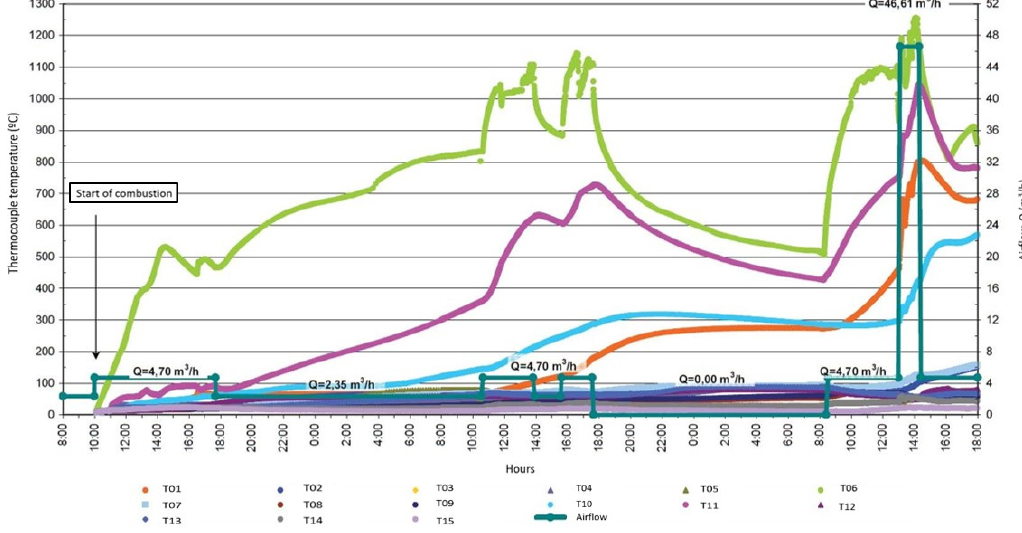
Figure 7. Temperature evolution over time in thermocouples during the experiment.